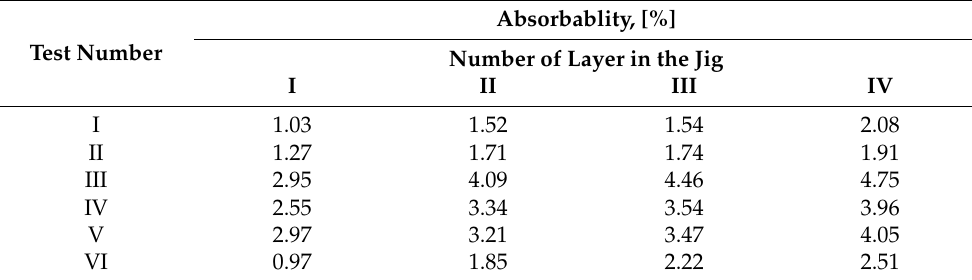
Table 5. Summary results of separation achieved in laboratory